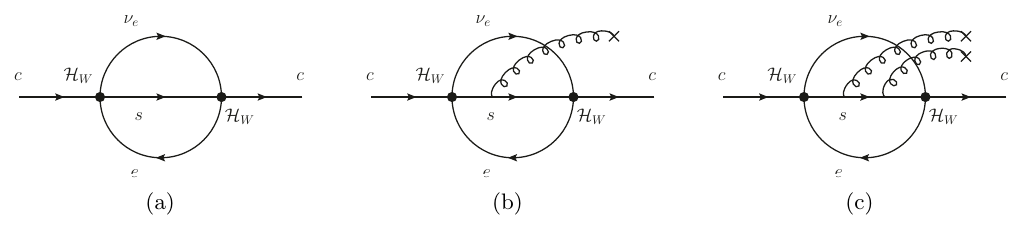
Figure 1 . The zero, one and two gluon matrix elements contributing to the OPE of y Im T ; W fH H W g